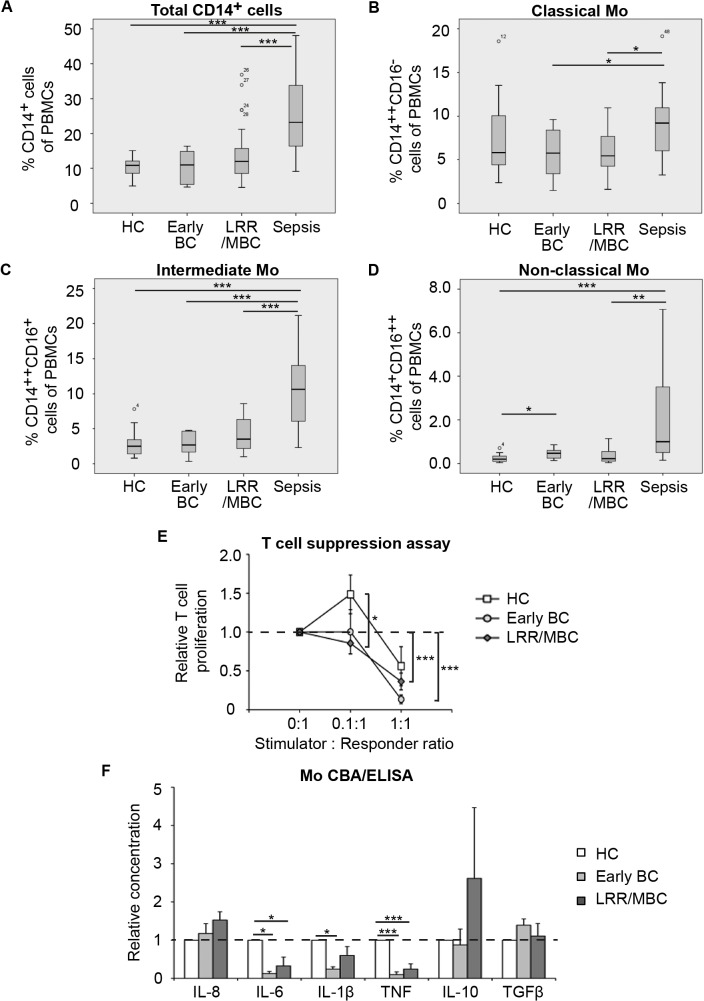
Monocytes from patients with advanced breast cancer display immunosuppressive properties.Flow cytometric analyzes of freshly isolated PBMCs from healthy controls (HC), patients with early breast cancer (BC), patients with advanced breast cancer (LRR/MBC) and patients with sepsis. (A-D) Total CD14+ monocytes (A), classical CD14++CD16- monocytes (B), intermediate CD14++CD16+ monocytes (C) and non-classical CD14+CD16++ monocytes (D) of PBMCs. HC n = 13, Early BC n = 10, LRR/MBC n = 18 and sepsis n = 11. Statistics performed by Mann-Whitney Wilcoxon test, * < 0.05, ** p < 0.01, *** p < 0.001. (E) Monocytes (stimulators) were co-cultured with CD3/CD28 stimulated allogeneic naïve CD4+ T cells (responders) from healthy donors at indicated stimulator:responder ratios. T cell proliferation was assessed by thymidine incorporation. HC n = 13, Early BC n = 10 and LRR/MBC n = 11. Lines represent mean relative proliferation, bars; SEM. Statistics by Student’s t-test * p < 0.05, *** p < 0.001. (F) The spontaneous production of IL-8, IL-6, IL-1β, TNF and IL-10 from monocytes cultured ex vivo for 24h was analyzed using CBA. Mean concentrations from healthy control monocytes were put to 1. HC n = 10, Early BC n = 9 and LRR/MBC n = 16. The spontaneous production of TGFβ was analyzed using ELISA. HC n = 5, Early BC n = 5 and LRR/MBC n = 5. Statistics by one-way ANOVA. * p < 0.05, *** p < 0.001.